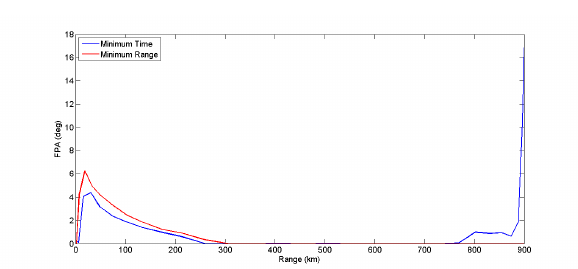
Fig. 7: Flight path angle profile for minimum time and minimum fuel